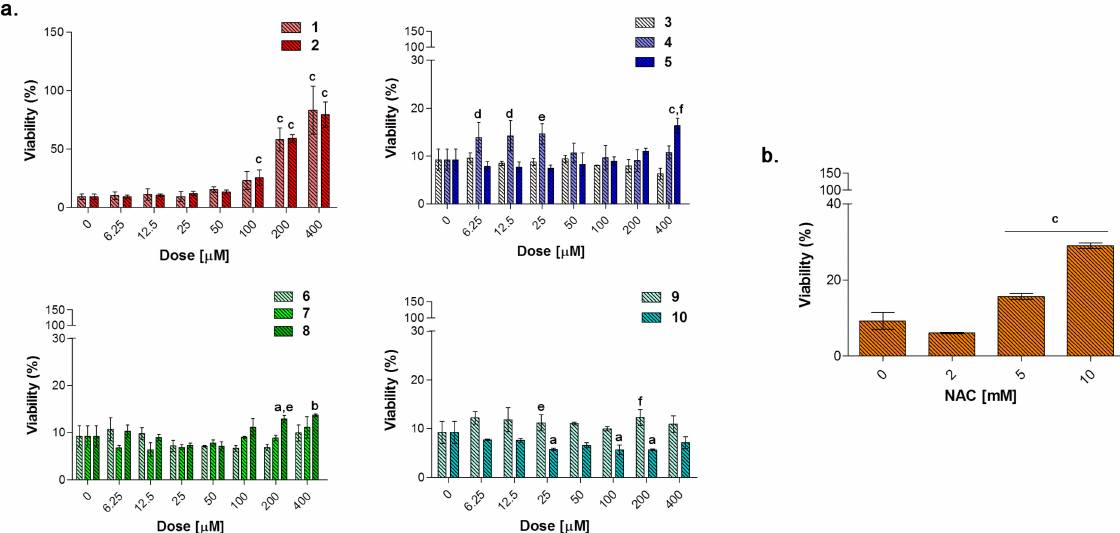
Figure 10. Cell metabolic activity of LPS-stimulated (0.1 µ g/mL) RAW 264.7 mouse macrophages in the presence of increasing concentrations (0–400 µ M) of compounds 1 – 10 ( a ) and NAC ( N -acetyl cysteine) (0–10 mM) ( b ) after 48 h. Data shown are the means ± S.D. of six replicates and are expressed as percentages of untreated cultures set as 100% (not shown). The 0 µ M concentration represents cells stimulated with 0.1 µ g/mL alone. (a = p < 0.05 between compounds or NAC and cells exposed to LPS alone; b = p < 0.01 between compounds or NAC and cells exposed to LPS alone; c = p < 0.001 between compounds or NAC and cells exposed to LPS alone; d = p < 0.05 between compounds at the same concentration; e = p < 0.01 between compounds at the same concentration; f = p < 0.001 between compounds at the same